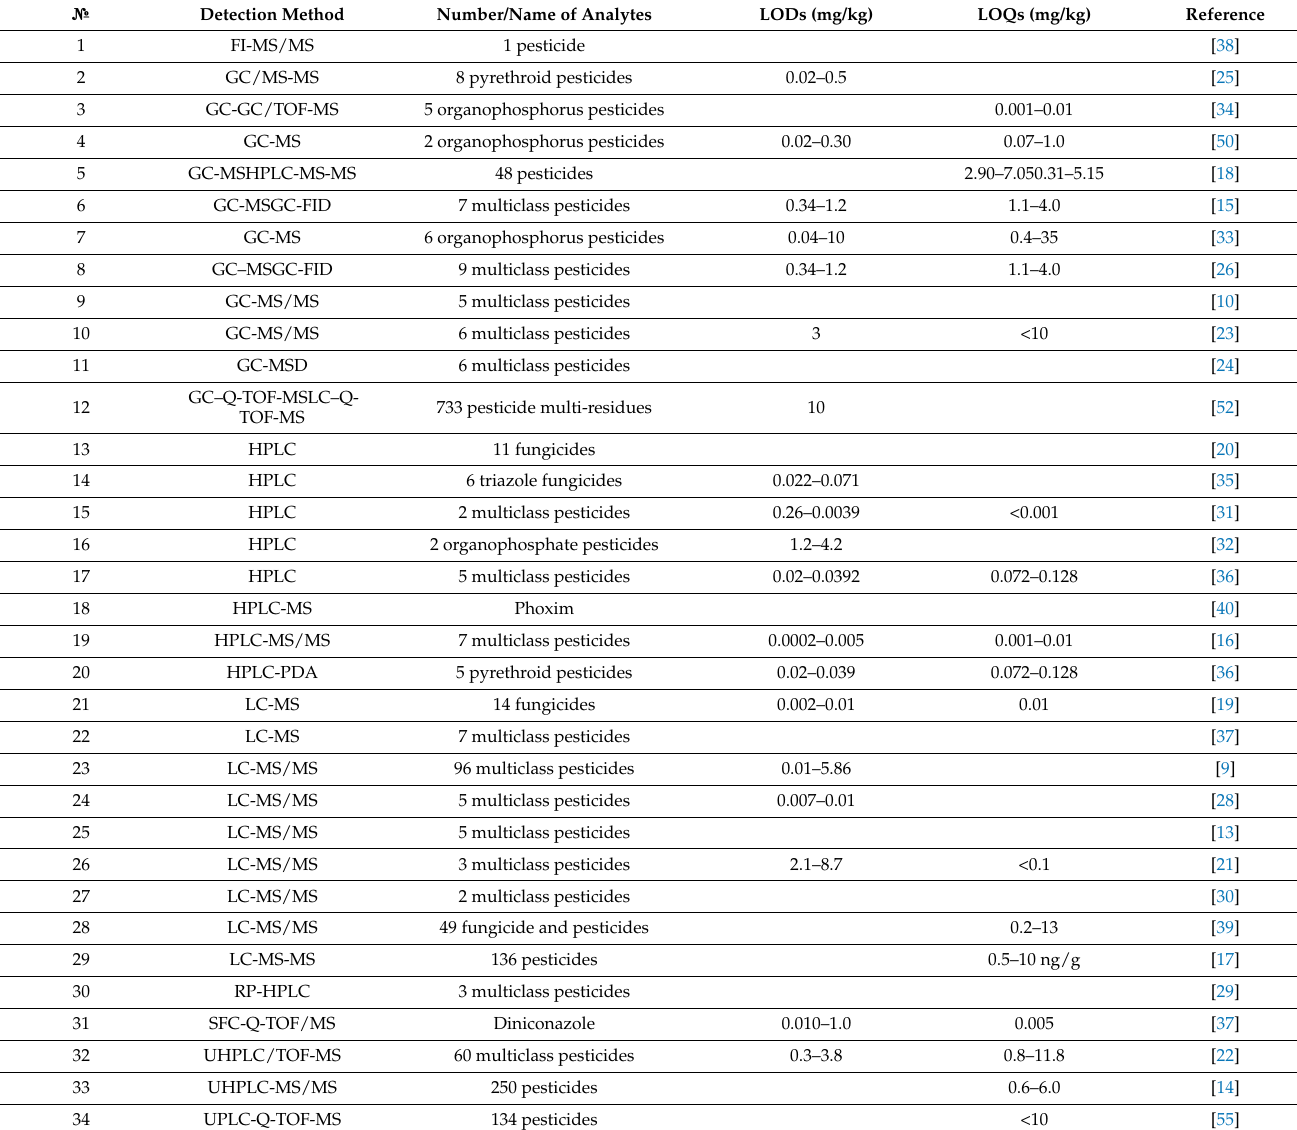
Table 3. Detection methods for assessing pesticide residues in fruits and